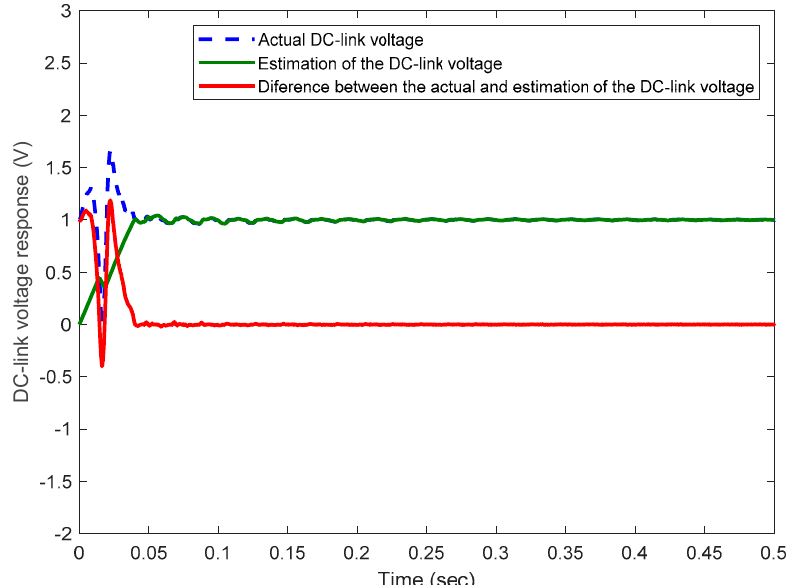
Figure 10. Dynamic performance of the adaptive fuzzy ESO for the DC ‐ link voltage.